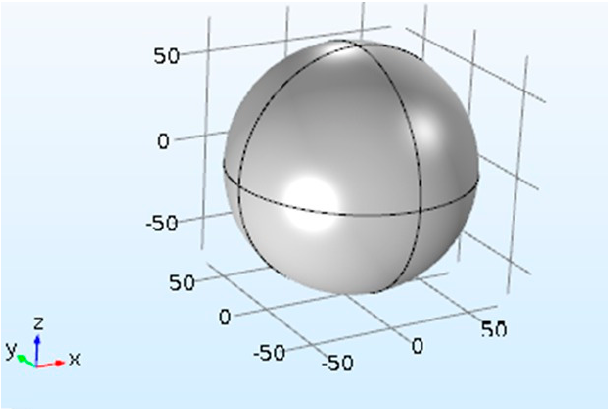
Figure 1. Gold nanosphere placed in uniform external electric field.